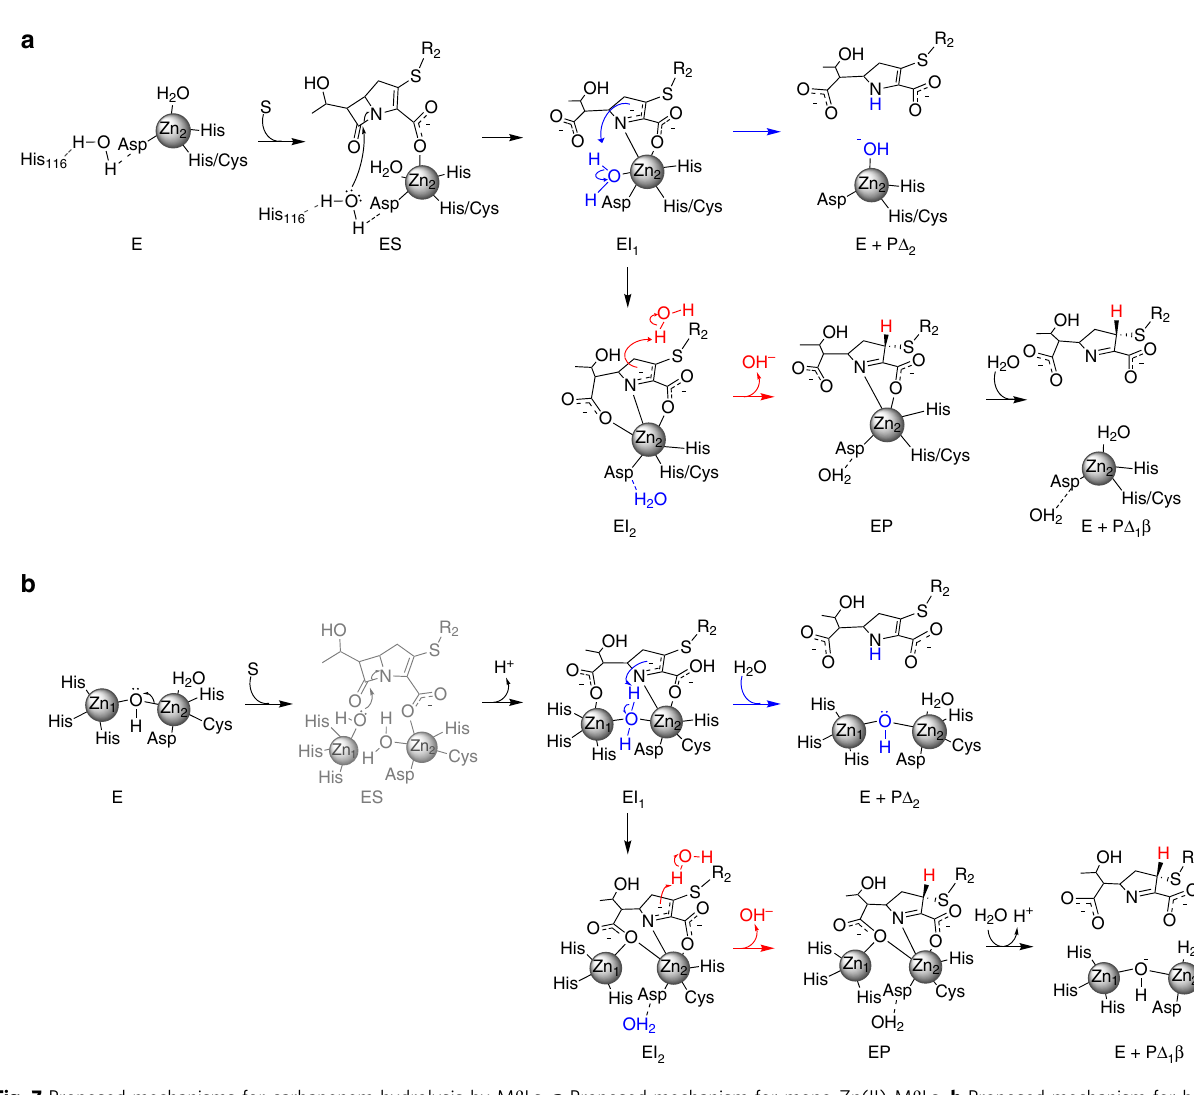
to achieve water suppression 57 ; the water-selective 180 °C sine-shaped pulse was 2 ms long. The FID was collected in 32 K data points. Prior to Fourier transfor- mation, a 1Hz exponential line broadening function was applied. TopSpin 3.0 was used to process and analyse NMR spectra. Signals were assigned based on the work of Ratcliffe et al. 39 . The same scaling ratio was used to plot all spectra in a given series. QM-MM calculations . For hybrid QM – MM calculations 58 , the QM subsystem was treated at the density functional level using the programme SIESTA 59 . Basis sets of double-f plus polarisation quality were employed for all atoms, with a pseudoatomic orbital energy shift of 30meV and a grid cutoff of 150 Ry. Basis sets of double zeta plus polarisation quality were employed for all atoms in the QM subsystem, and all calculations were performed using the generalized gradient approximation functional proposed by Perdew, Burke, and Ernzerhof (PBE) 60 . The Amber99 force fi eld parametrization was used to treat the classical subsystem 61 . The initial structures were taken from the experimental X-ray data: pdb code 4rbs and 4eyl 32 . Hydrogen atoms were added using Amber14 leap module 62 . Both